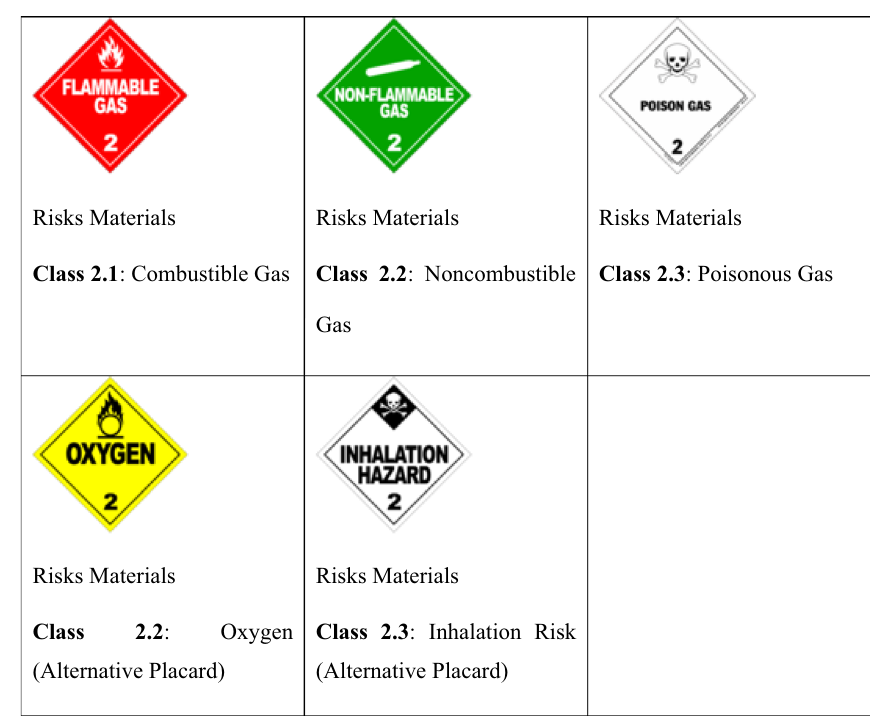
Fig. 2 Class 3, Combustible